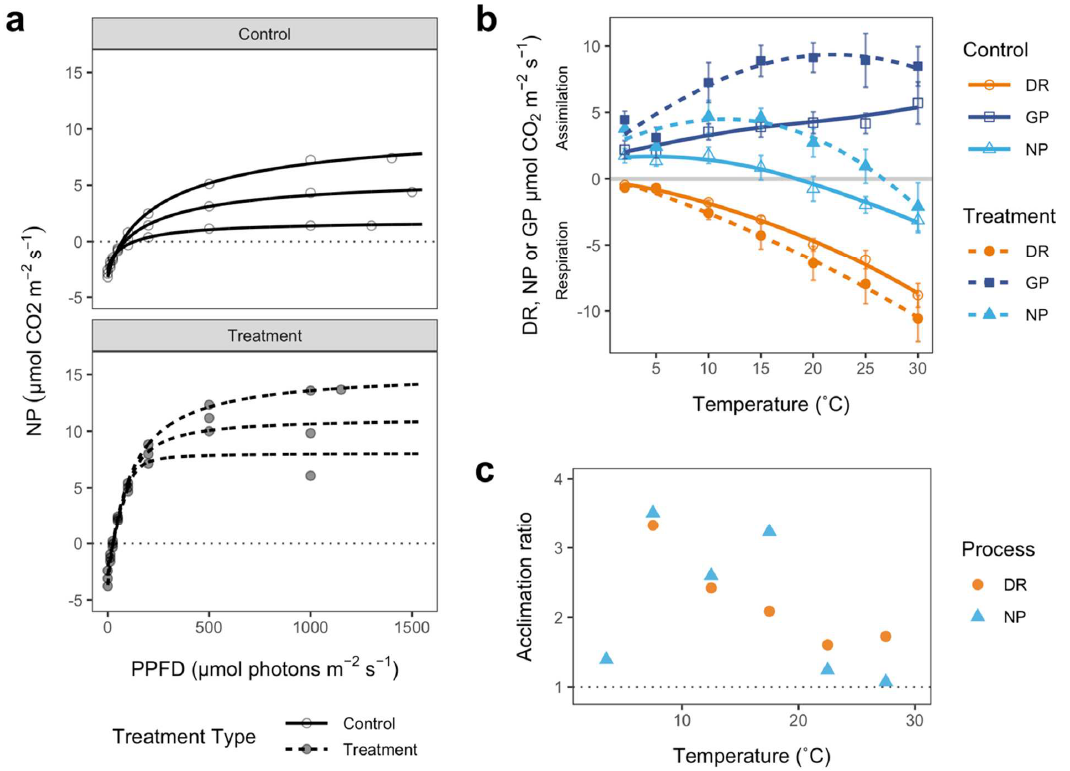
Figure 3. Physiological responses of B. argenteum var. muticum in response to the pulse warming experiment. ( a ) Light response curves for control (top) and treatment (bottom); ( b ) the response of net photosynthesis (NP, light blue ▲ ), dark respiration (DR, orange ) and gross photosynthesis (GP, dark blue ■ ) to temperature. The symbols are actual data means ± SE at each temperature, with hollow symbols for control values and filled symbols for treatment values. The fitted lines (solid for control and dashed for treatment) were obtained from nonlinear curve fitting of the entire data set in R. NP: control, R 2 = 95.8%, p = 0.0008; treatment, R 2 = 87.6%, p = 0.0068. DR: both control and treatment, R 2 = 99.2%, p < 0.0001; ( c ) acclimation ratios for NP (light blue ▲ ) and DR (orange ) at various temperatures, calculated from average treatment and control rates per surface area. Dotted line indicates an acclimation ratio of 1.0 (acclimation as identical rates of control and treatment at respective growth temperatures).